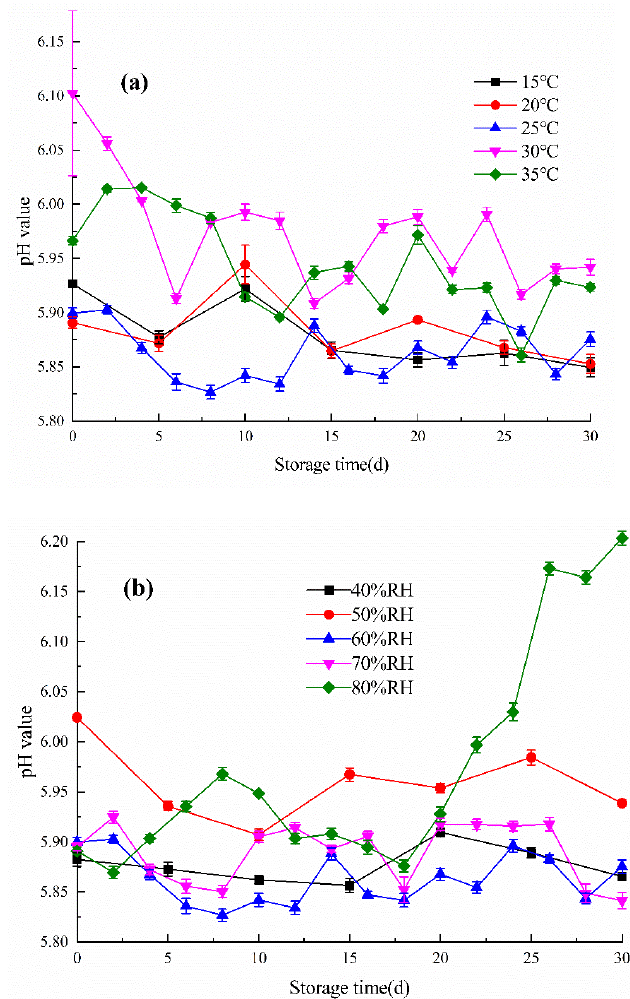
Figure 3. The trend for the pH value of fishmeal: ( a ) at 15 ◦ C, 20 ◦ C, and 25 ◦ C, 30 ◦ C, and 35 ◦ C; ( b ) at 40% RH, 50% RH, 60% RH, 70% RH, and 80% RH.